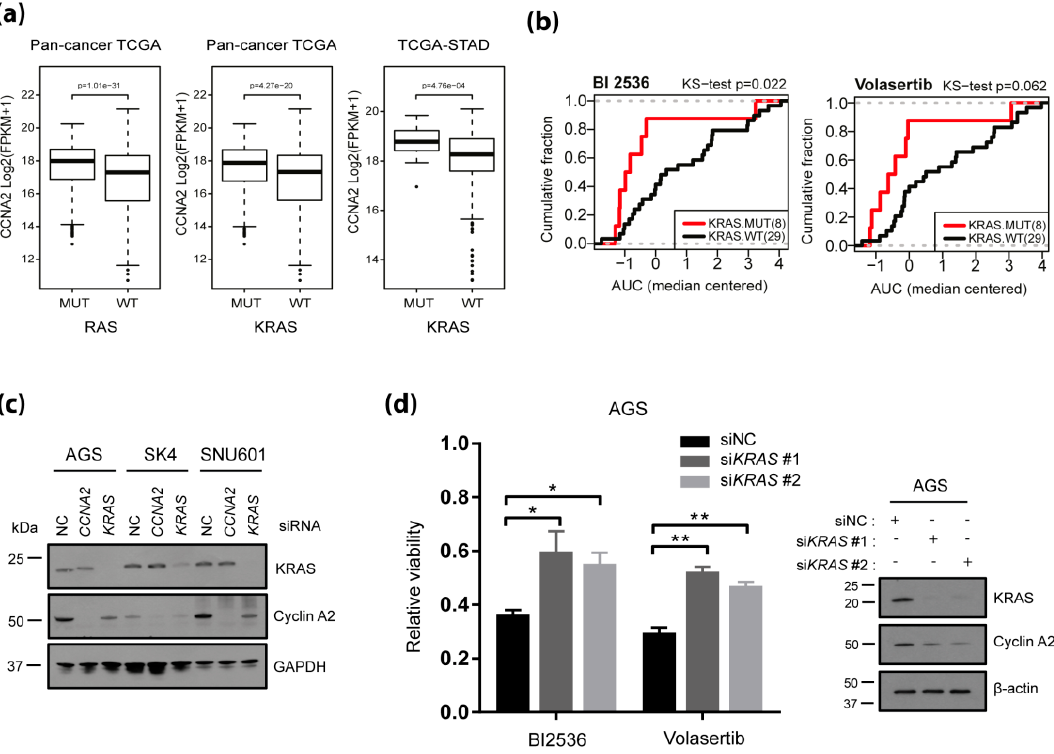
Figure 4. Oncogenic KRAS driven CCNA2 upregulation confers sensitivity of KRAS mutant cancer to PLK1 inhibitors.( a ) Comparison of CCNA2 expression levels between wild-type (WT) and pan- RAS ( KRAS , HRAS and NRAS ) or mutant KRAS tumor samples (pan-cancer and gastric cancer) in the Cancer Genome Atlas (TCGA) cohort; ( b ) cumulative distribution fraction plots of drug response (median-centered AUC) in the 37 gastric cancer cell lines show that KRAS mutant cell lines had higher sensitivity to BI-2536 and volasertib. p values were calculated by two-sided Kolmogorov–Smirnov tests (KS-test); ( c ) evaluation of cyclin A2 and KRAS expression by immunoblotting post knockdown of CCNA2 and KRAS in KRAS mutant gastric cancer cell lines (AGS, SK4 and SNU601). GAPDH was measured as an internal control; ( d ) relative viability of AGS cells expressing siKRASoligos at 72 h post treatment with BI-2536 (0.16µM) and volasertib (0.16µM). Expression changes of KRAS and cyclin A2 by expression of siKRASoligos were observed by immunoblotting. * p <0.05, ** p <0.01; Student’s t- test; ( e ) relative viability of AGS cells expressing siKRAS with or without CCNA2 cDNA at 72 h post BI-2536 (0.16µM and 0.5µM) treatment. Expression changes of KRAS and cyclin A2 were assessed by immunoblotting. ** p <0.01, *** p <0.001; two-way ANOVA; ( f ) Hypothetical model of selective toxicity to PLK1 inhibitor in KRAS mutant cancer.